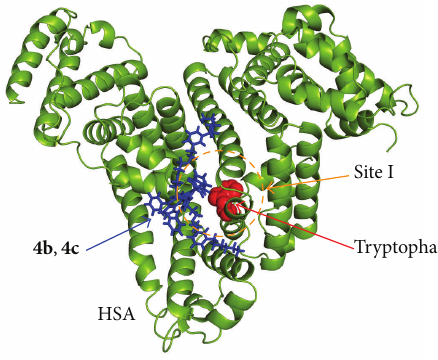
Scheme 8: Binding of 4b - 4c on Site I of HAS.